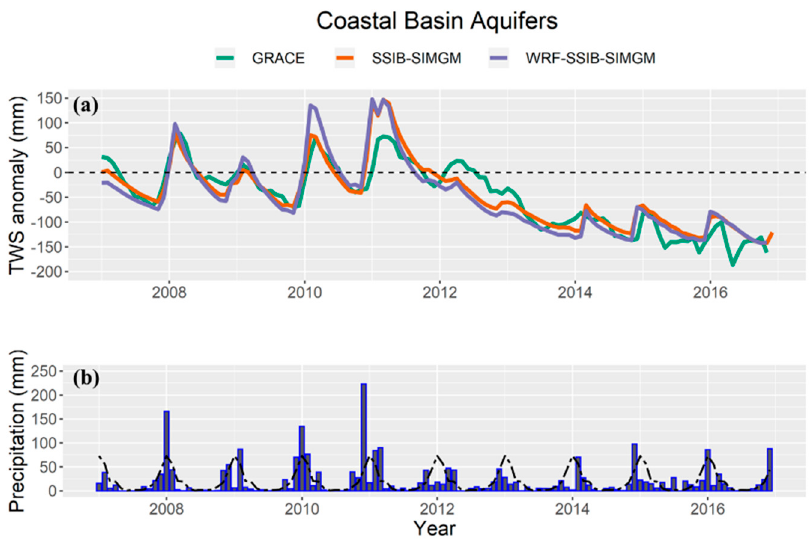
Figure 3. ( a ) GRACE, SSIB-SIMGM, and WRF-SSIB-SIMGM monthly TWS anomalies based on the 2007–2010 baseline and ( b ) monthly precipitation for the Coastal Basin aquifer system between 2007 and 2016. Dashed line in ( b ) represents an average precipitation annual cycle over the aquifer.